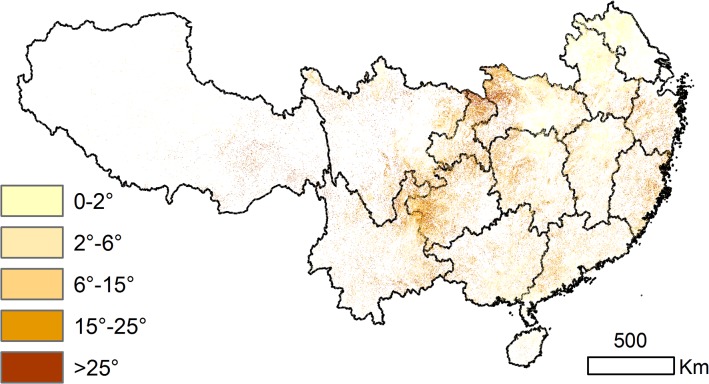
The slope distributions in the area with significantly increased EVI 2000–2009.